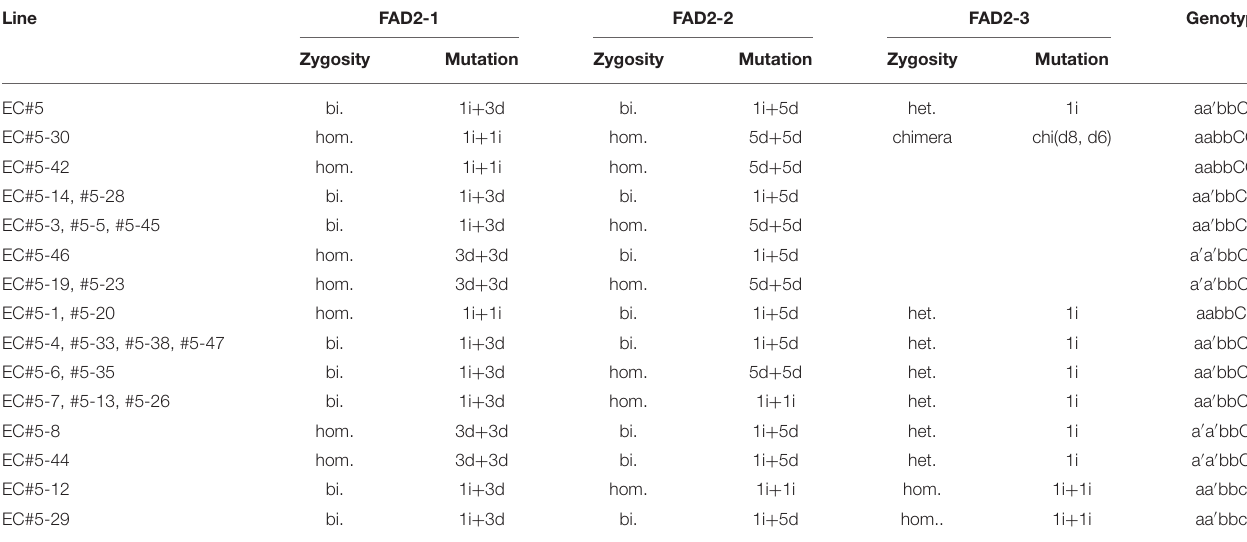
TABLE 1 | Genotypes of Camelina progenies of EC#5 using Sanger sequencing following homoeolog-specific PCR.